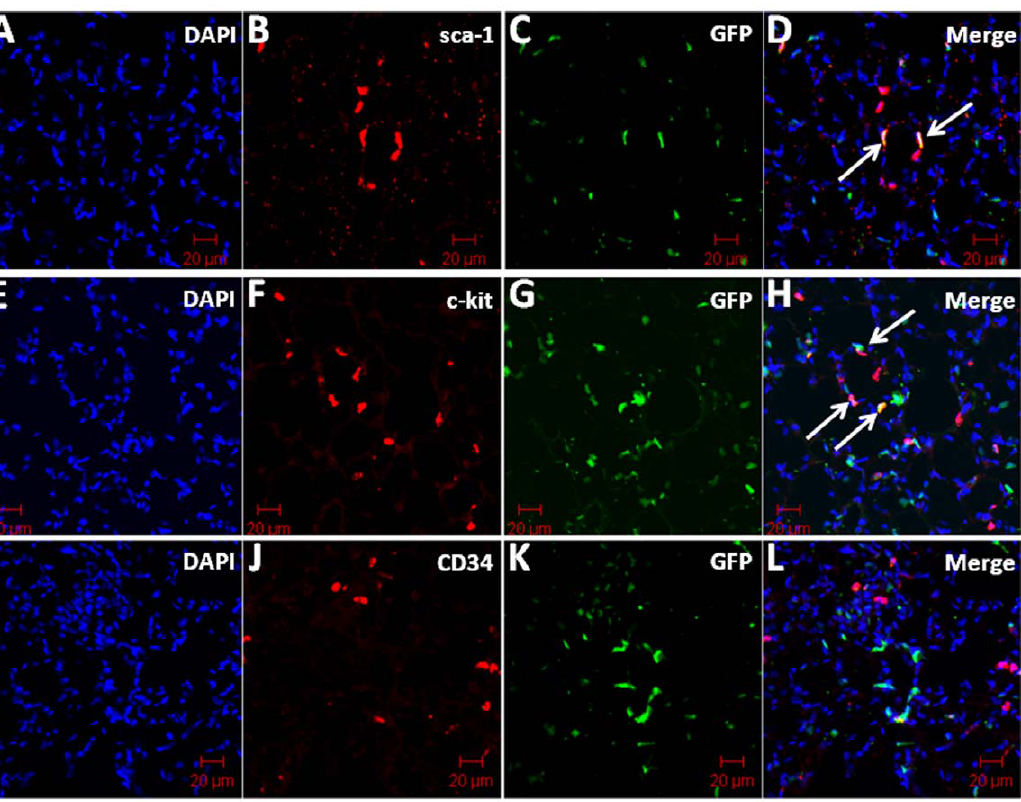
Figure 5. GFP and cellular markers sca-1 and c-kit co-localize in AAV-HIMF-treated bone marrow transplant recipients. Frozen lung sections from bone marrow transplant recipients treated with AAV-HIMF (2.5 6 10 10 VP, 14d) were stained with antibodies for (B) sca-1, (F) c-kit, or (J) CD34 (red). (C, G, K) GFP signal was obtained through direct visualization (green). (A, E, I) Cell nuclei were counterstained with DAPI (blue). (D, H, L) The arrows in the merged images demonstrate co-localization of GFP with the cellular markers. Scale bar: 20 m m.